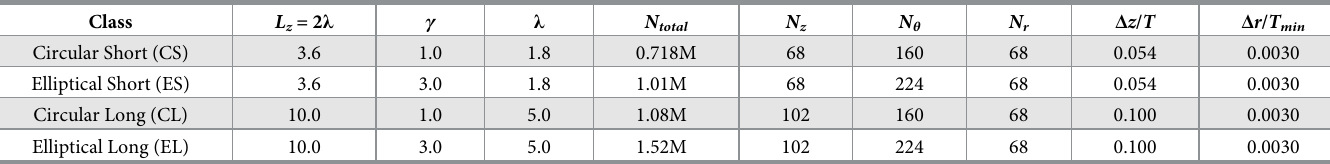
Table 4. Mesh variation by geometry class.